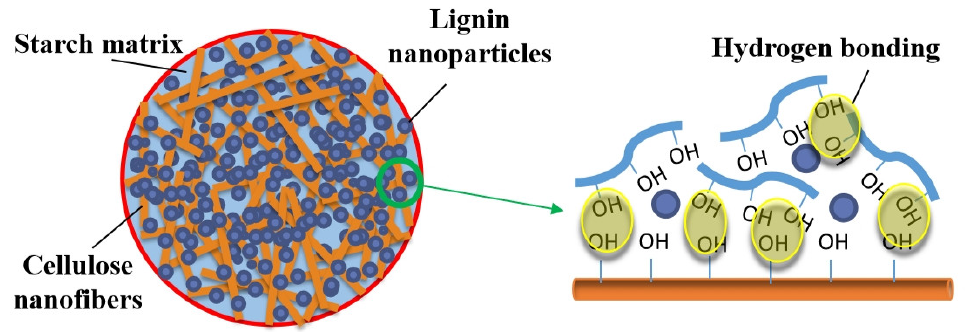
Figure 7. Schematic illustration of bonding mechanism of CNF, starch, and lignin in the